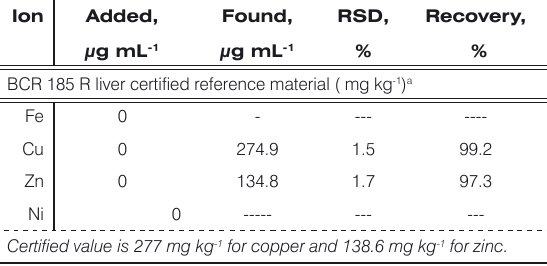
Ni 0 ----- --- --- Certified value is 277 mg kg -1 for copper and 138.6 mg kg -1 for zinc. Table 4. Recovery of trace elements from spiked spinach and soil samples after application of presented procedure Ion Added, Found, RSD, % Recovery, µg g -1 µg g -1 %